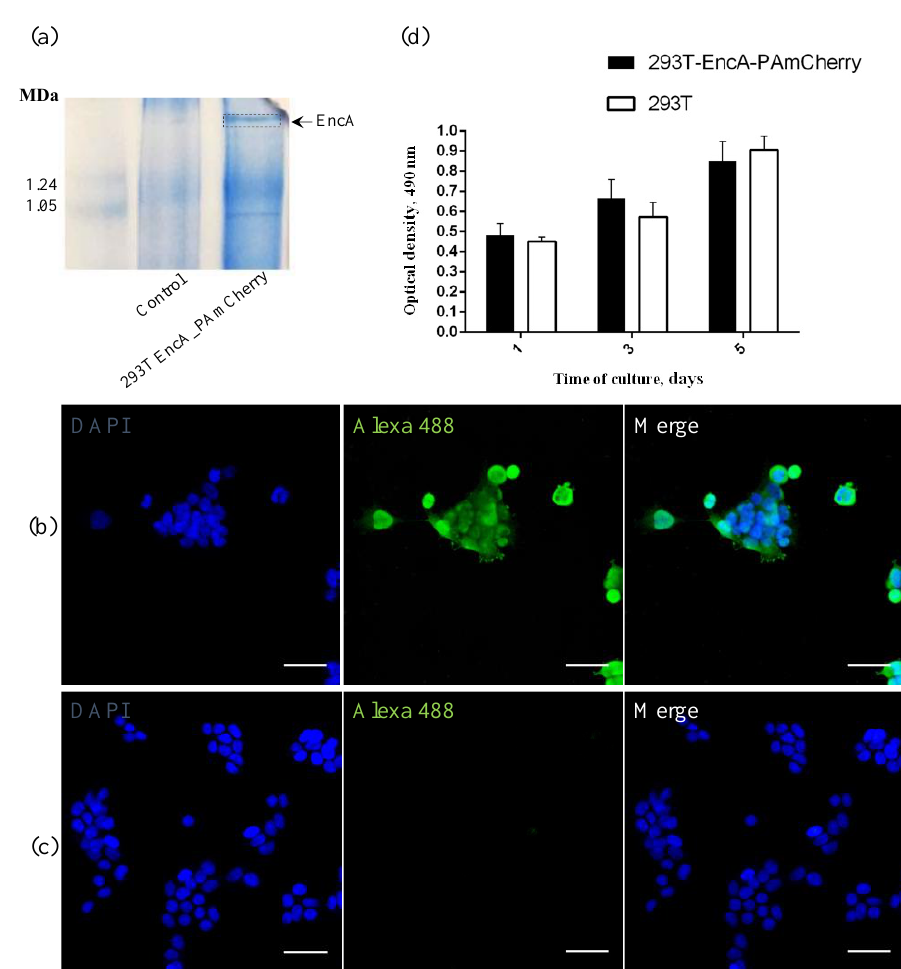
Figure 1. ( a ) Coomasie-stained BN-PAGE gels loaded with 293T and 293T EncA_PAmCherry cell lysates. Arrow and dotted line indicate the band corresponding to Mx EncA protein shells; ( b ) 293T EncA_PAmCherry and ( c ) 293T cells stained with Alexa Fluor 488 anti-DYKDDDDK Tag antibody (green fluorescence signal). Nuclei were counterstained with DAPI (blue fluorescence signal). Laser scanning confocal microscopy, Nikon Eclipse Ti2, scale bars are 50 μm; ( d ) Influence of the presence of a genetically encoded label on viability and proliferation of 293T EncA_PAmCherry cells. Optical density is proportional to the number of living cells. The numbers of living cells were not significantly different in 293T EncA_PAmCherry and 293T cells. The data are shown as the mean + S.D. of three independent experiments, p values were calculated using a one-tailed t -test, assuming unequal variances.